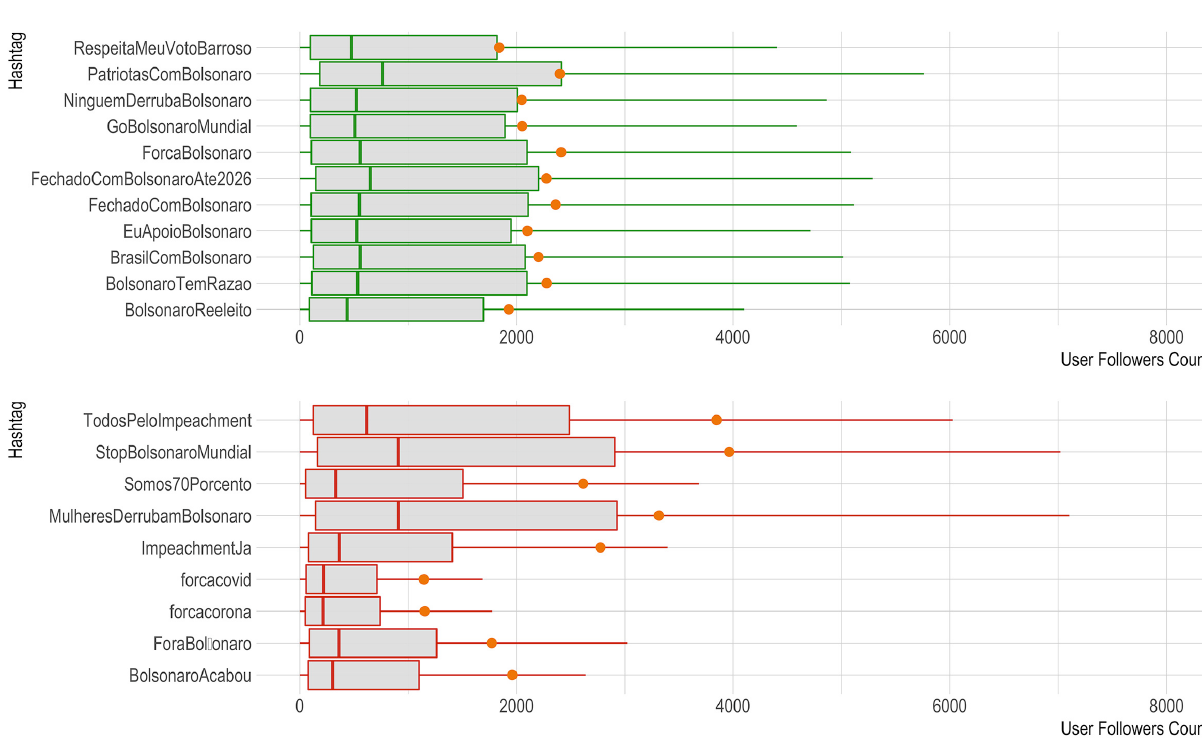
Figure 2. User followers count per